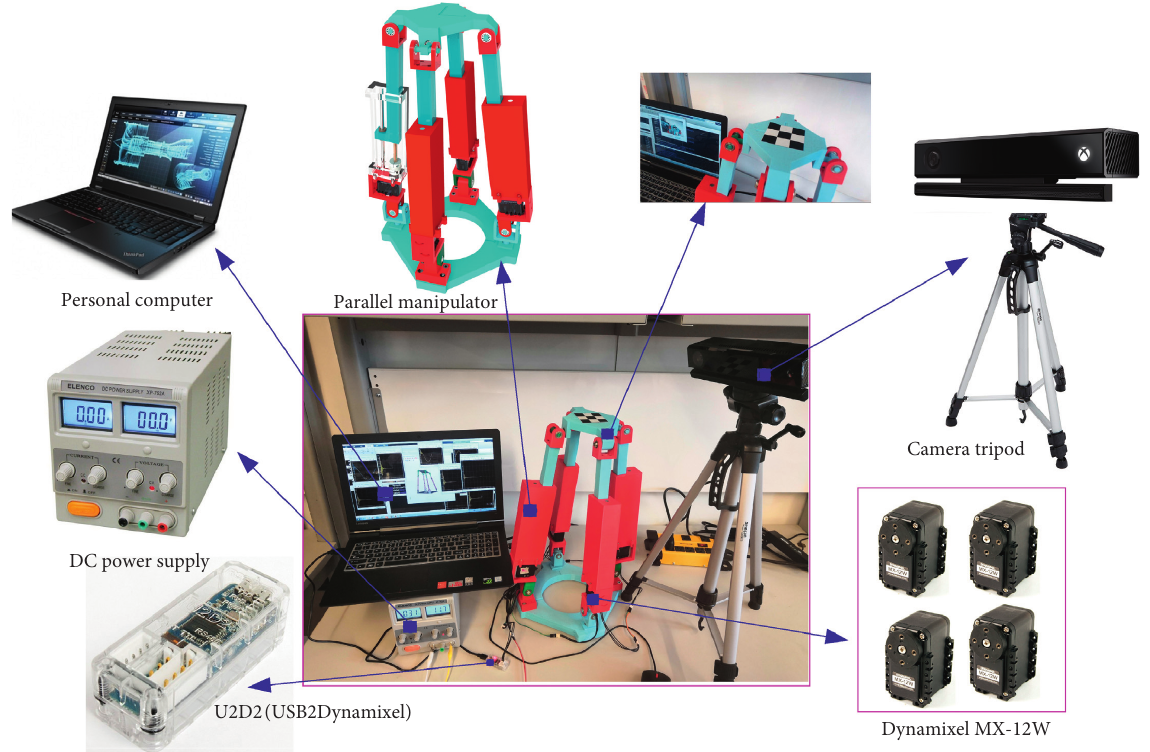
Figure 5: The simulation and experimental platform of the parallel manipulator.